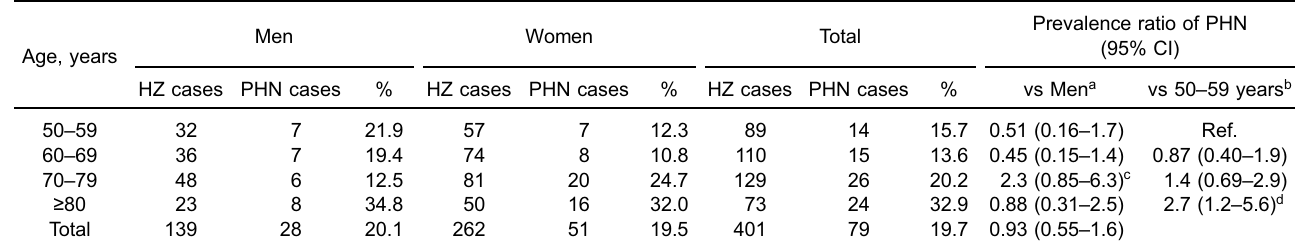
Table 4. The population of postherpetic neuralgia among the herpes zoster cases Men Age, years